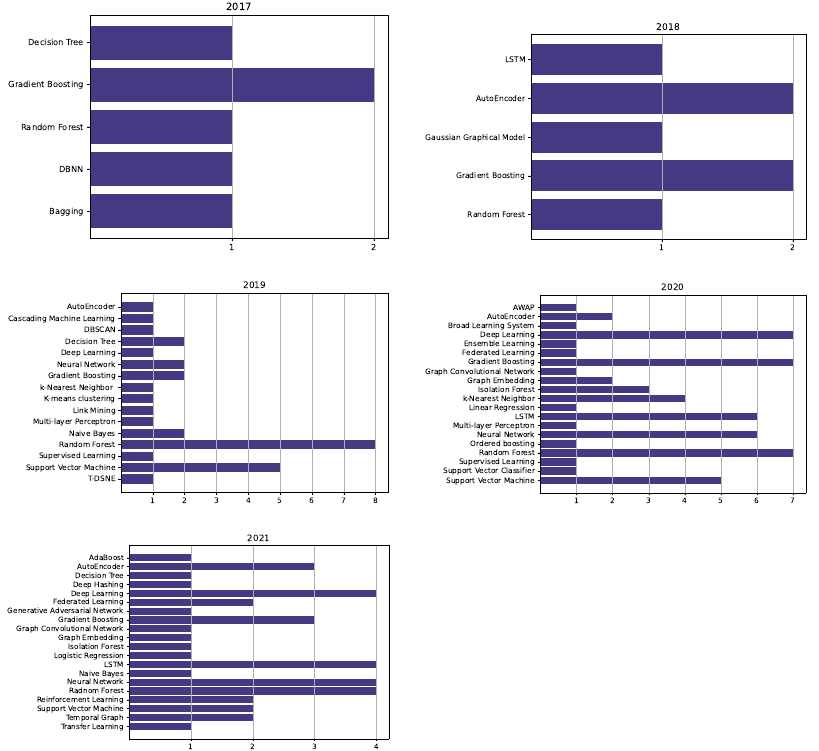
Figure 4. Distribution of used methods per